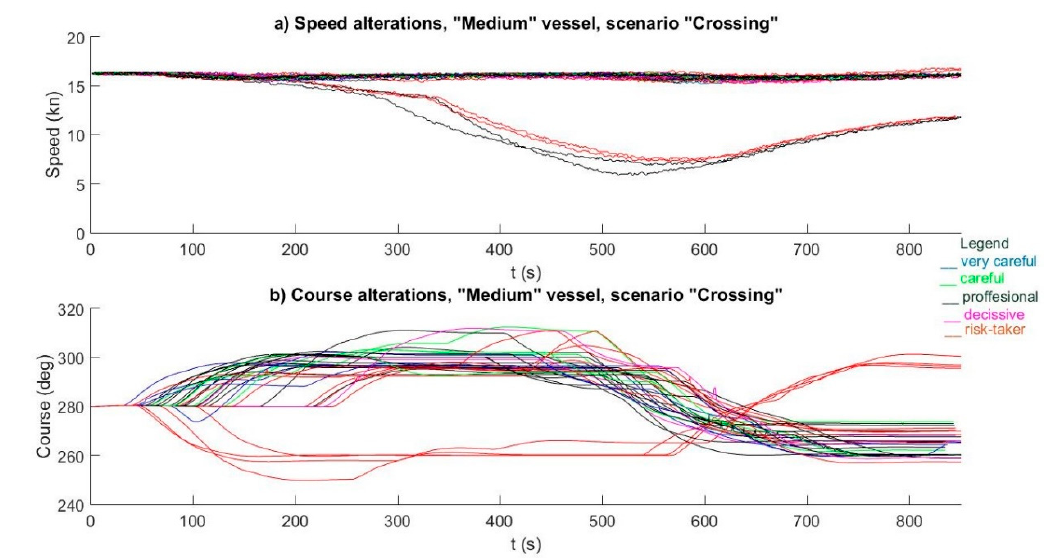
Figure 5. Alterations of ship speed and course. Medium ship, ‘Crossing’.